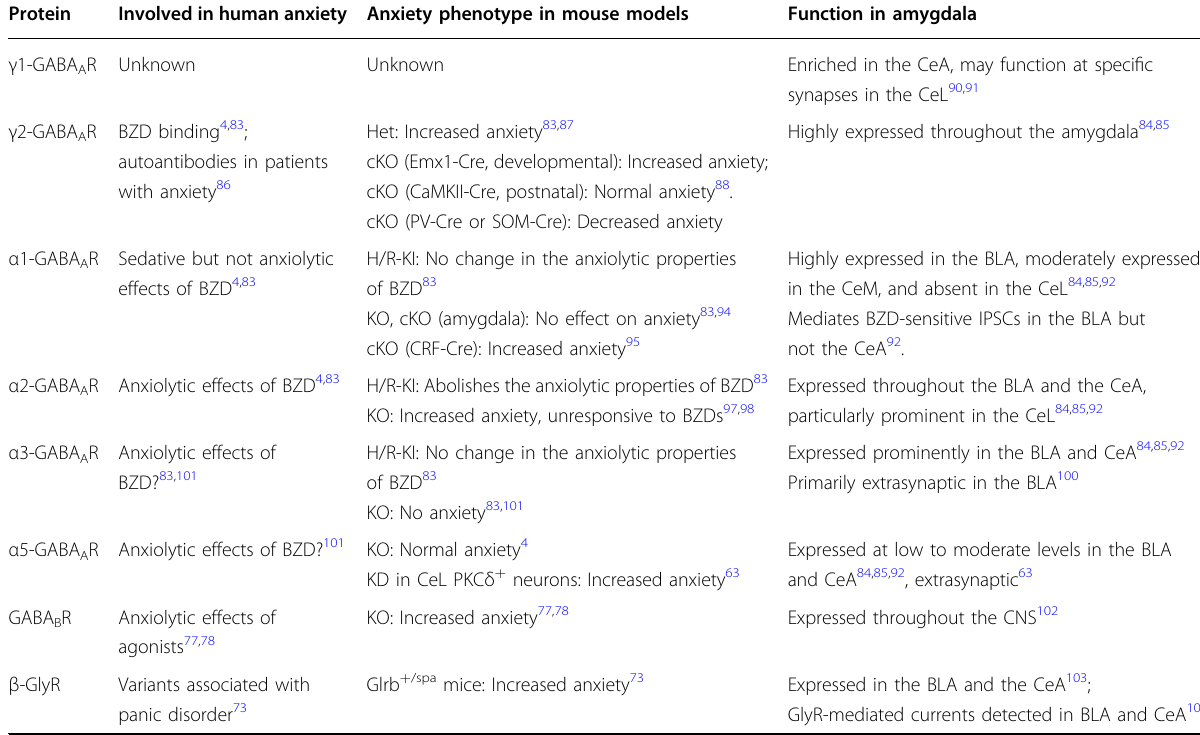
Table 2 Inhibitory receptors that are linked to the amygdala anxiety circuitry Protein Involved in human anxiety Anxiety phenotype in mouse models Function in